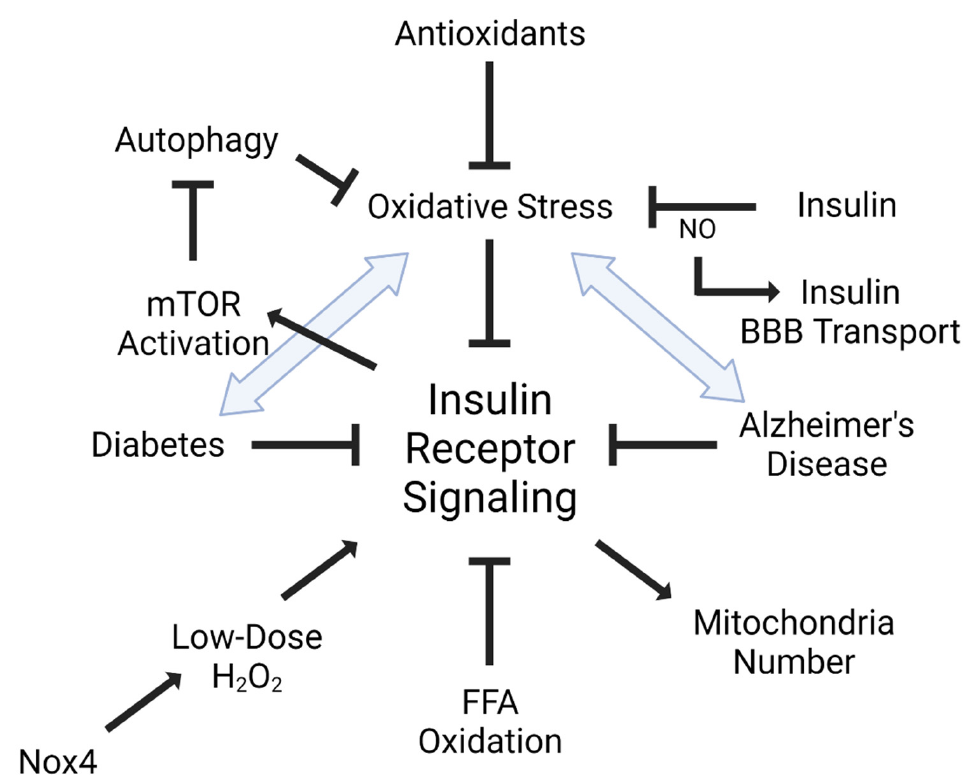
Figure 2. Interaction between insulin and oxidative stress. Insulin receptor signaling is tightly linked with oxidative stress. Dysregulated or impaired insulin receptor signaling is also defined as insulin resistance. Not only does oxidative stress, including free fatty acid (FFA) oxidation, impair insulin receptor signaling, but insulin receptor signaling can also activate mTOR to inhibit autophagy and oxidative stress. It is also known that insulin receptor signaling can regulate mitochondria number, which can be blocked by oxidative stress. Additionally, low doses of oxidative stress can have a positive impact on insulin receptor signaling, mediated by the NADPH oxidase, Nox4. Nitric oxide (NO) can regulate insulin BBB transport. Diseases implicated in insulin receptor signaling, such as diabetes mellitus (DM) and Alzheimer’s disease (AD), are heavily linked to oxidative stress. Figure generated using BioRender.